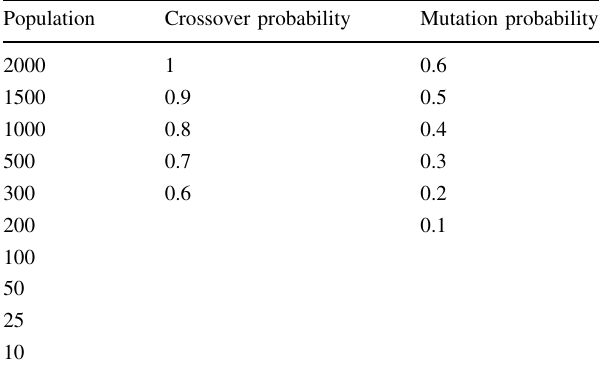
Table 3 Tested values of the parameters for NSGA-II and